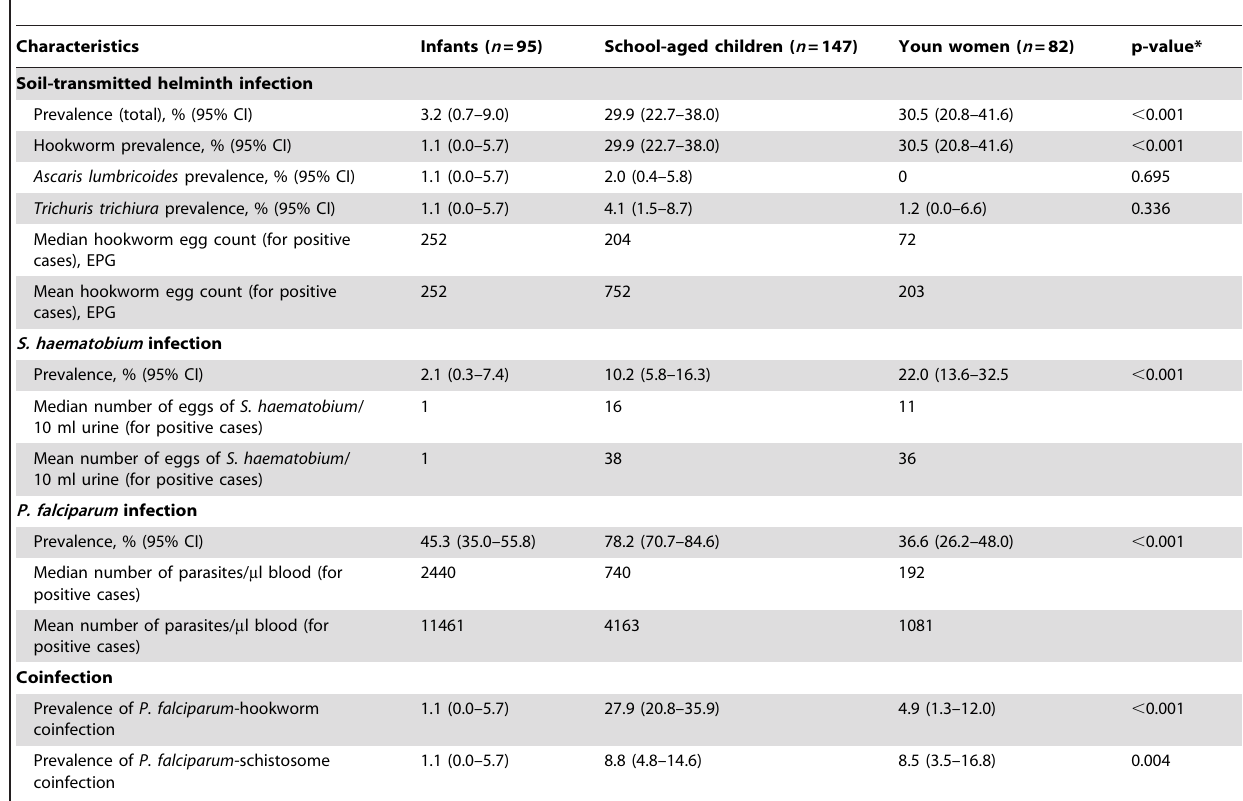
Table 1. Baseline characteristics of soil-transmitted helminth, schistosome, and P. falciparum infections in three different age